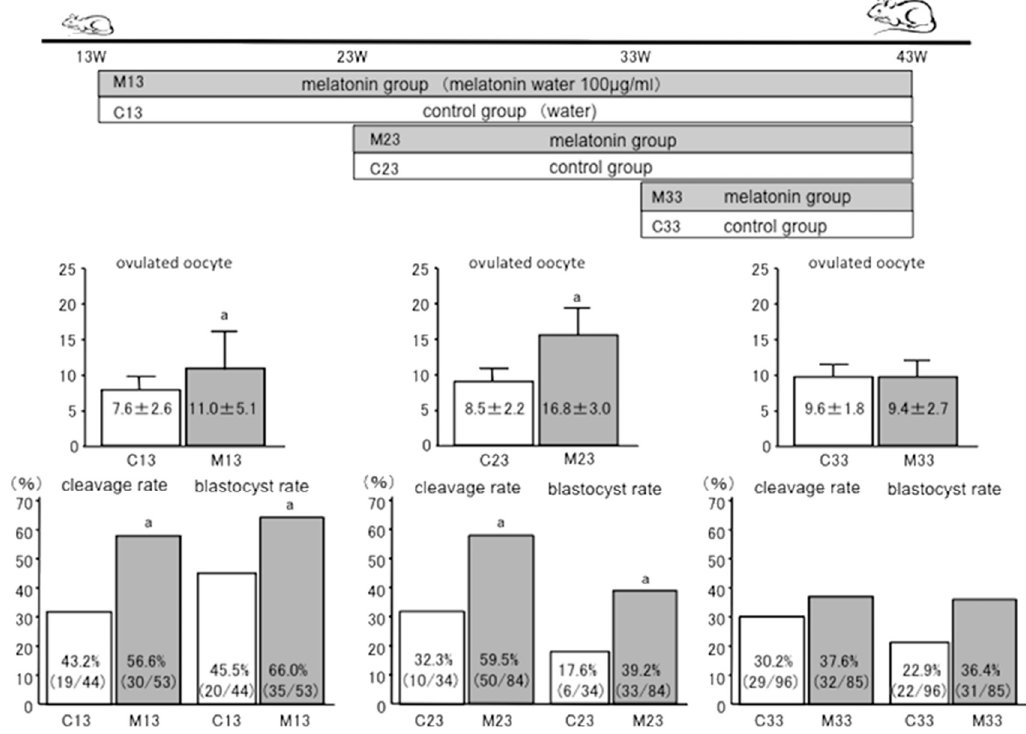
Figure 5. The anti-aging e ff ects of melatonin on ovaries depends on the age of initiation of melatonin treatment. Melatonin treatment was started from 23 weeks (M23 weeks; melatonin group: M23, control group: C23) or 33 weeks (M33 weeks; melatonin group: M33, control group: C33) of age in mice, and the results of IVF outcomes at 43 weeks of age were analyzed. In the 23-week group, the number of ovulated oocytes (8.5 ± 2.2, C23; 16.8 ± 3.0, M23), fertilization rate (32.3%, C23; 59.5%, M23), and blastocyst rate (17.6%, C23; 39.2%, M23) were all significantly higher in the melatonin group than the control animals, and melatonin was found to have an anti-aging e ff ect on the ovaries. On the other hand, in the 33-week group, the number of ovulated oocytes (9.6 ± 1.8, C33; 9.4 ± 2.7, M33), fertilization rate (30.2%, C33; 37.6%, M33), and blastocyst rate (22.9%, C33; 36.4%, M33) showed no significant di ff erence between the melatonin treated and control